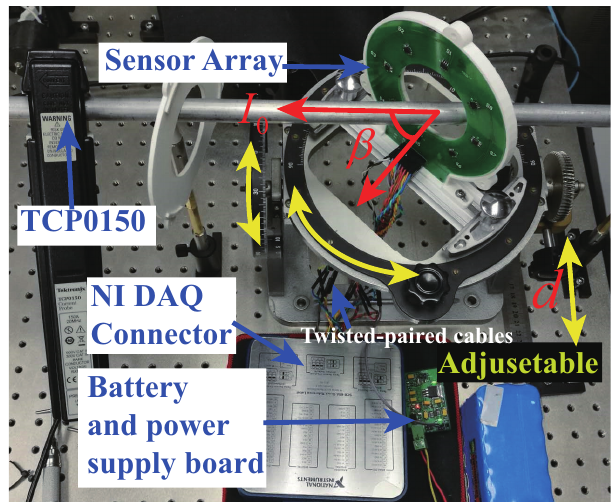
Figure 5. Experimental setup with adjustable